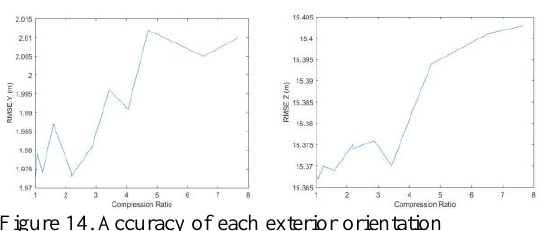
Figure 14. Accuracy of each exterior